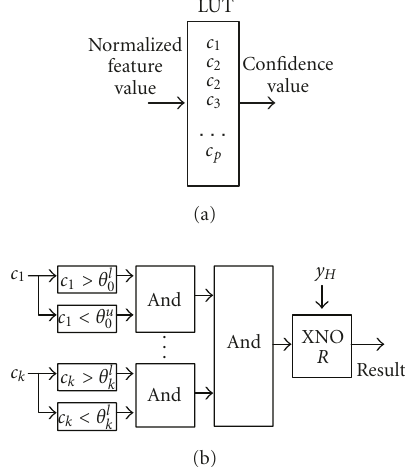
Figure 7: A possible structure of the strong classifier.